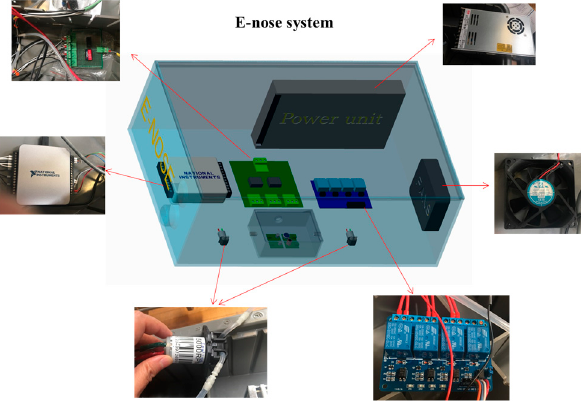
Figure 2. Illustration of E-nose system.